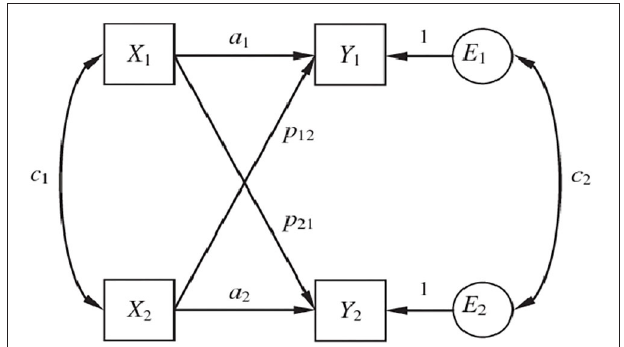
FIGURE 1 | Theoretical APIM